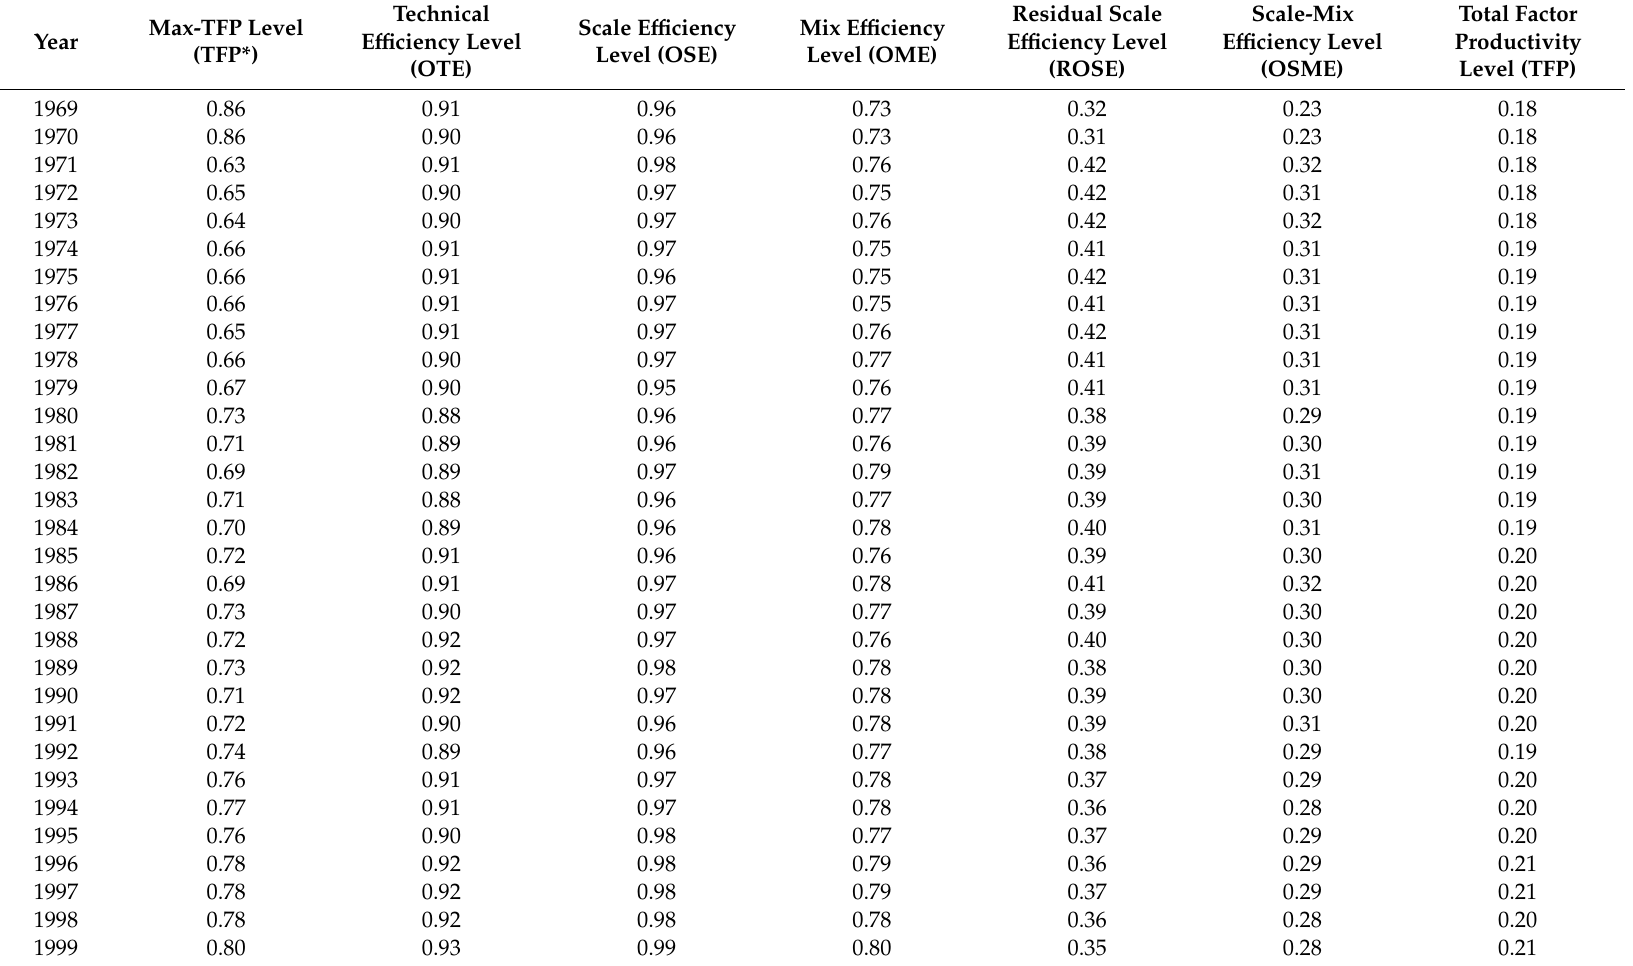
Table 2. Global total factor productivity and e ffi ciency levels (Geometric means